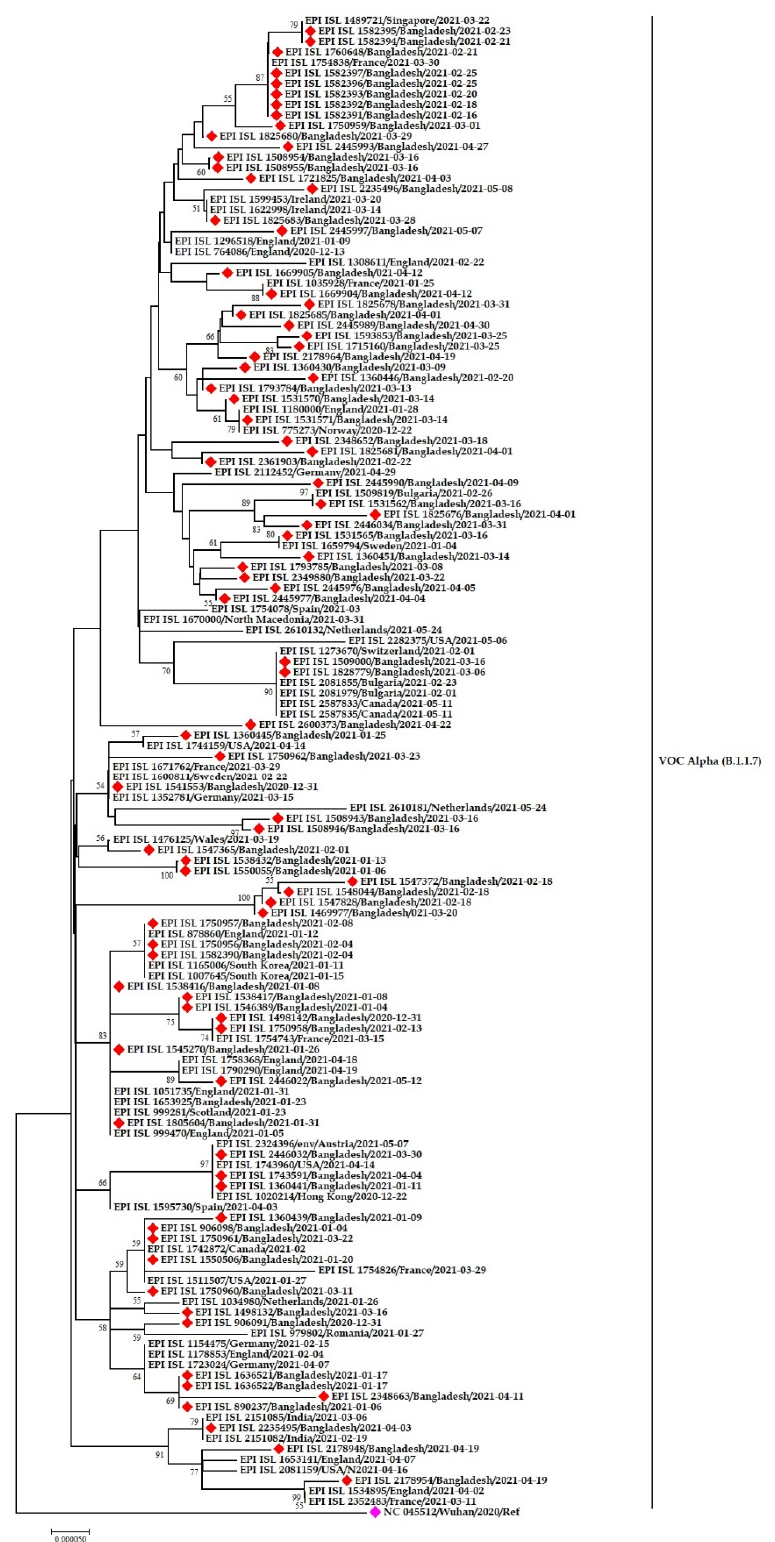
Figure 7. Phylogenetic analysis of emerging Alpha variants of SARS-CoV-2 in Bangladesh. Here, red diamond dots denote Bangladeshi Alpha variants SARS-CoV-2 viruses, and pink dots denote the Wuhan-Hu-1 viruses.